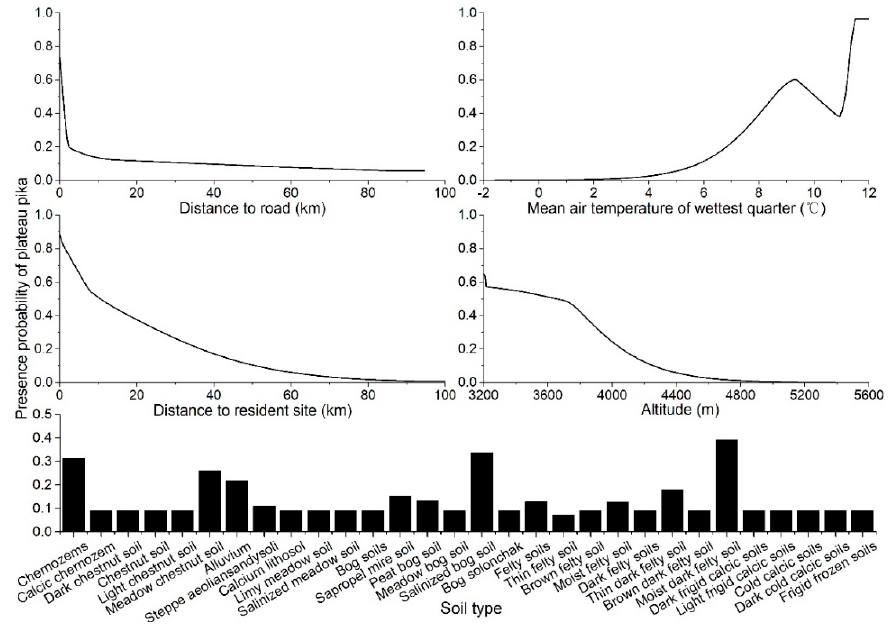
Figure 4. Response curves illustrating the relationship between the presence probability of plateau pika and macrohabitat factors in the Qinghai Lake basin.